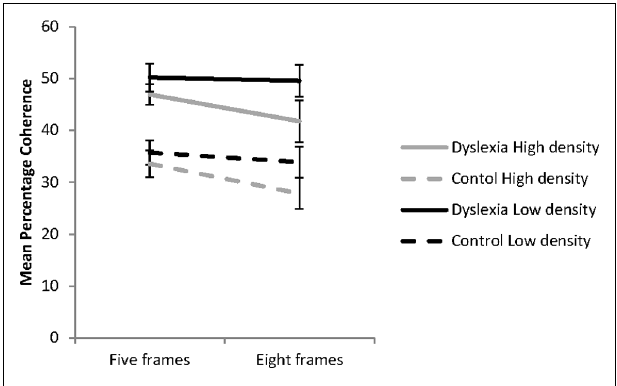
FIGURE 1 | Coherent motion thresholds for the effects of dot density and the number of animation frames presented for the groups with ( n = 21) and without dyslexia ( n = 22) in each of the four experimental conditions. Error bars represent ± 1 standard